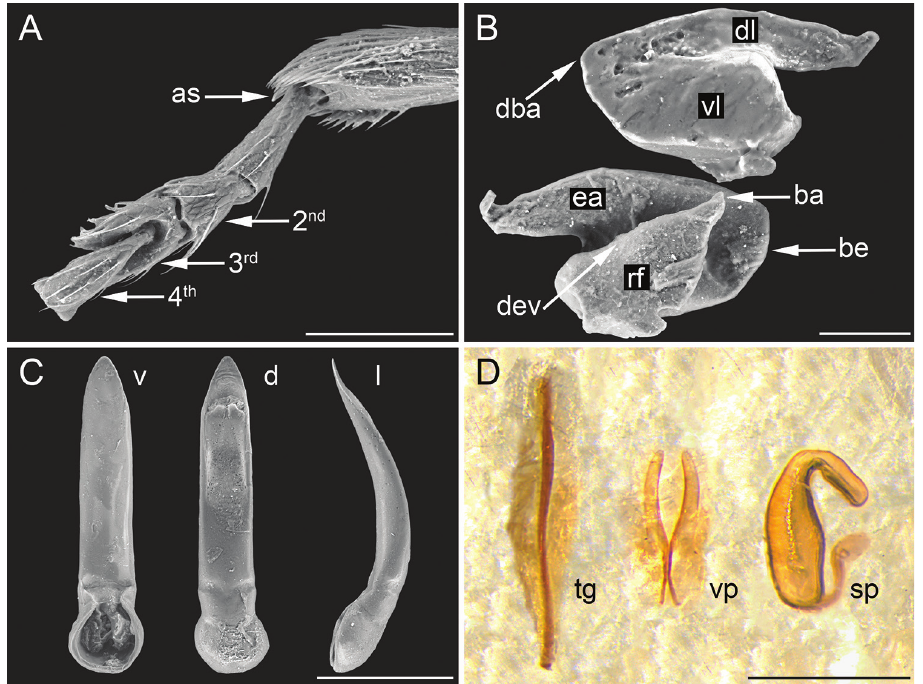
Figure 3. Morphological characters of Ugandaltica wagneri sp. n. A Distal part of hind tibia, and hind tarsus: 2 nd = second tarsomere, 3 rd = third tarsomere, 4 th = fourth visible tarsomere, as = apical spur of hind tibia B Metafemoral extensor tendon: ba = basal angle of ventral lobe, be = basal edge of tendon, dba = dorsal-basal angle of tendon, dl = dorsal lobe, dev = dorsal edge of ventral lobe, ea = extended arm of dorsal lobe, rf = recurve flange, vl = ventral lobe C Aedeagus: d = dorsal view, l = lateral view, v = ven- tral view D Female genitalia: sp = spermatheca, tg = tignum, vp = vaginal palpi. Scale bar: 100 µm ( A ); 50 µm ( B ); 200 µm ( C , D